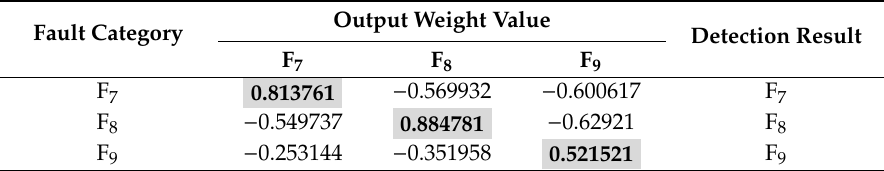
Table 5. Fault detection results under the failure of di ff erent switches in c -phase (inverter frequency = 60 Hz).